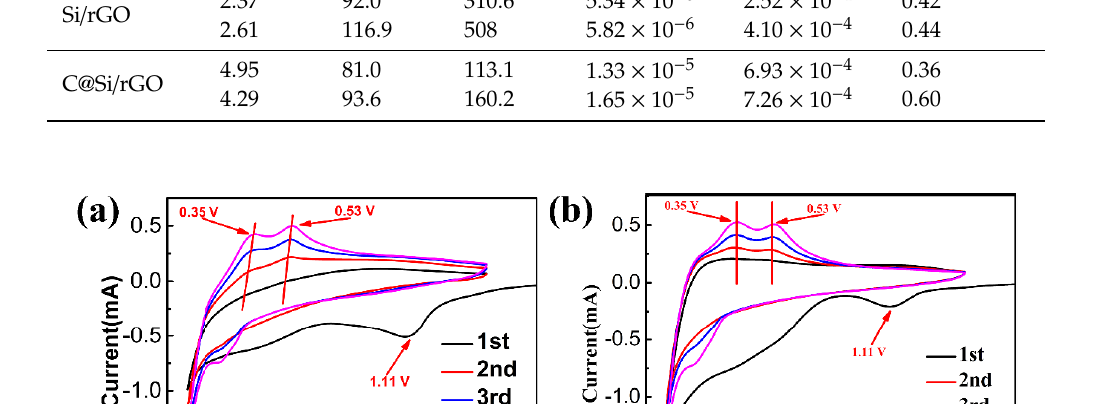
Figure 6. ( a ) and (b) Galvanostatic discharge/charge curves of Si/rGO and C@Si/rGO film electrodes; ( c ) long-term cycling performances of Si/rGO and C@Si/rGO film electrodes at current density of 100 mAg − 1 ; ( d ) rate capabilites of Si/rGO and C@Si/rGO film electrodes under different current rates. Table 2. Equivalent circuit parameters obtained from fitting the experimental impedance spectra (Figure 7c).